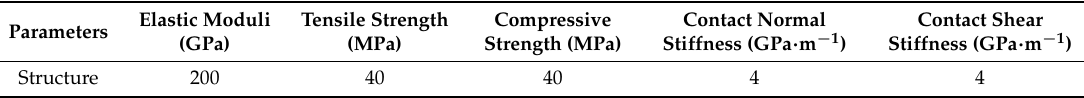
Table 6. Properties of the support element in the UDEC.